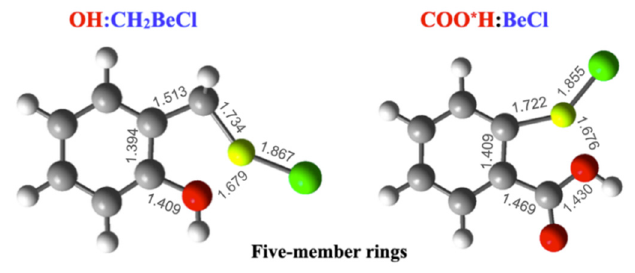
Figure 5. Comparison between different kinds of five-member rings depending on the donor (OH and COO * H). The same applies for larger rings. Distances are provided in Å.